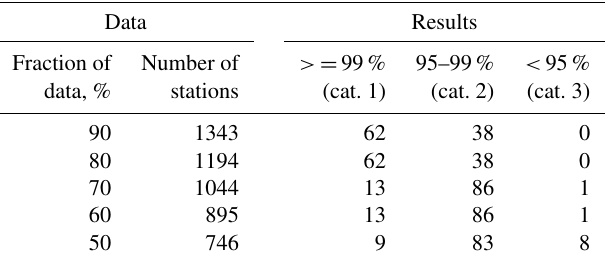
Table 8. Similarities (percentages of stations assigned to identical clusters) between reference CA runs and runs based on data sets with excluded years (see